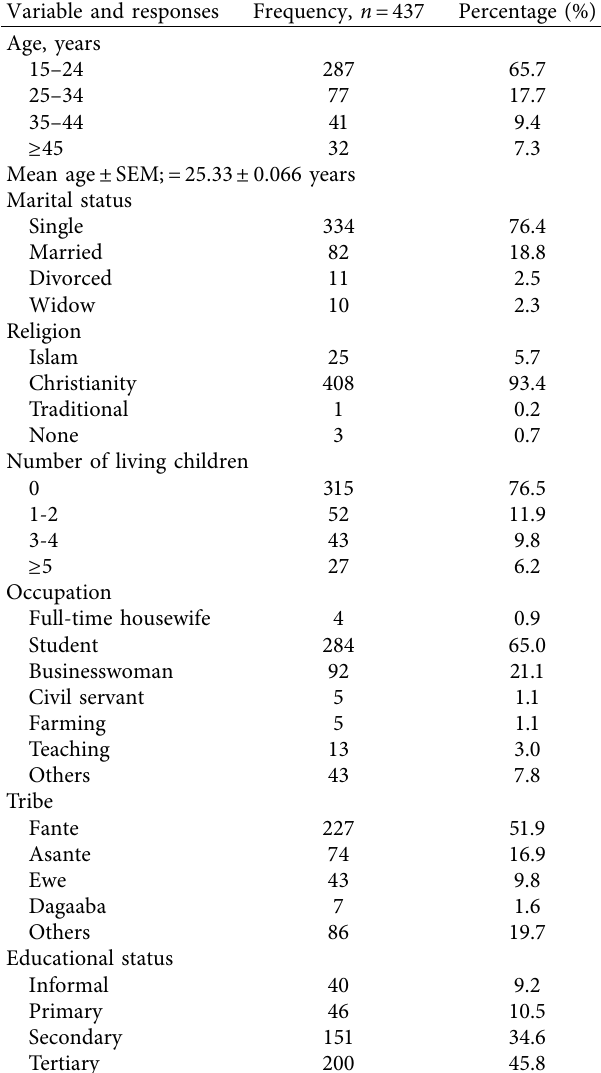
Table 1: Respondents’ sociodemographic